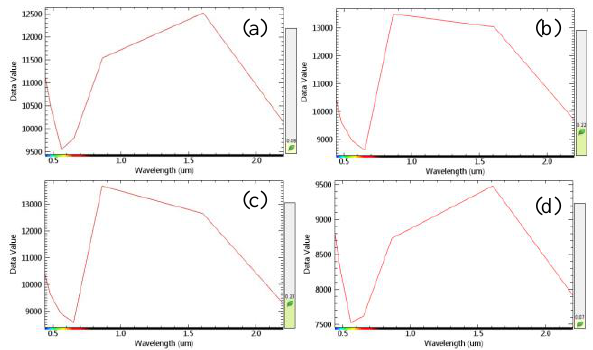
Figure 4 Spectrograms of saline-alkali fields in OLI sensor images in different seasons. (a)Landsat 8 OLI 2016/03/03,(b) Landsat 8 OLI 2017/09/30, (c) Landsat 8 OLI 2016/12/16,(d) Landsat 8 OLI